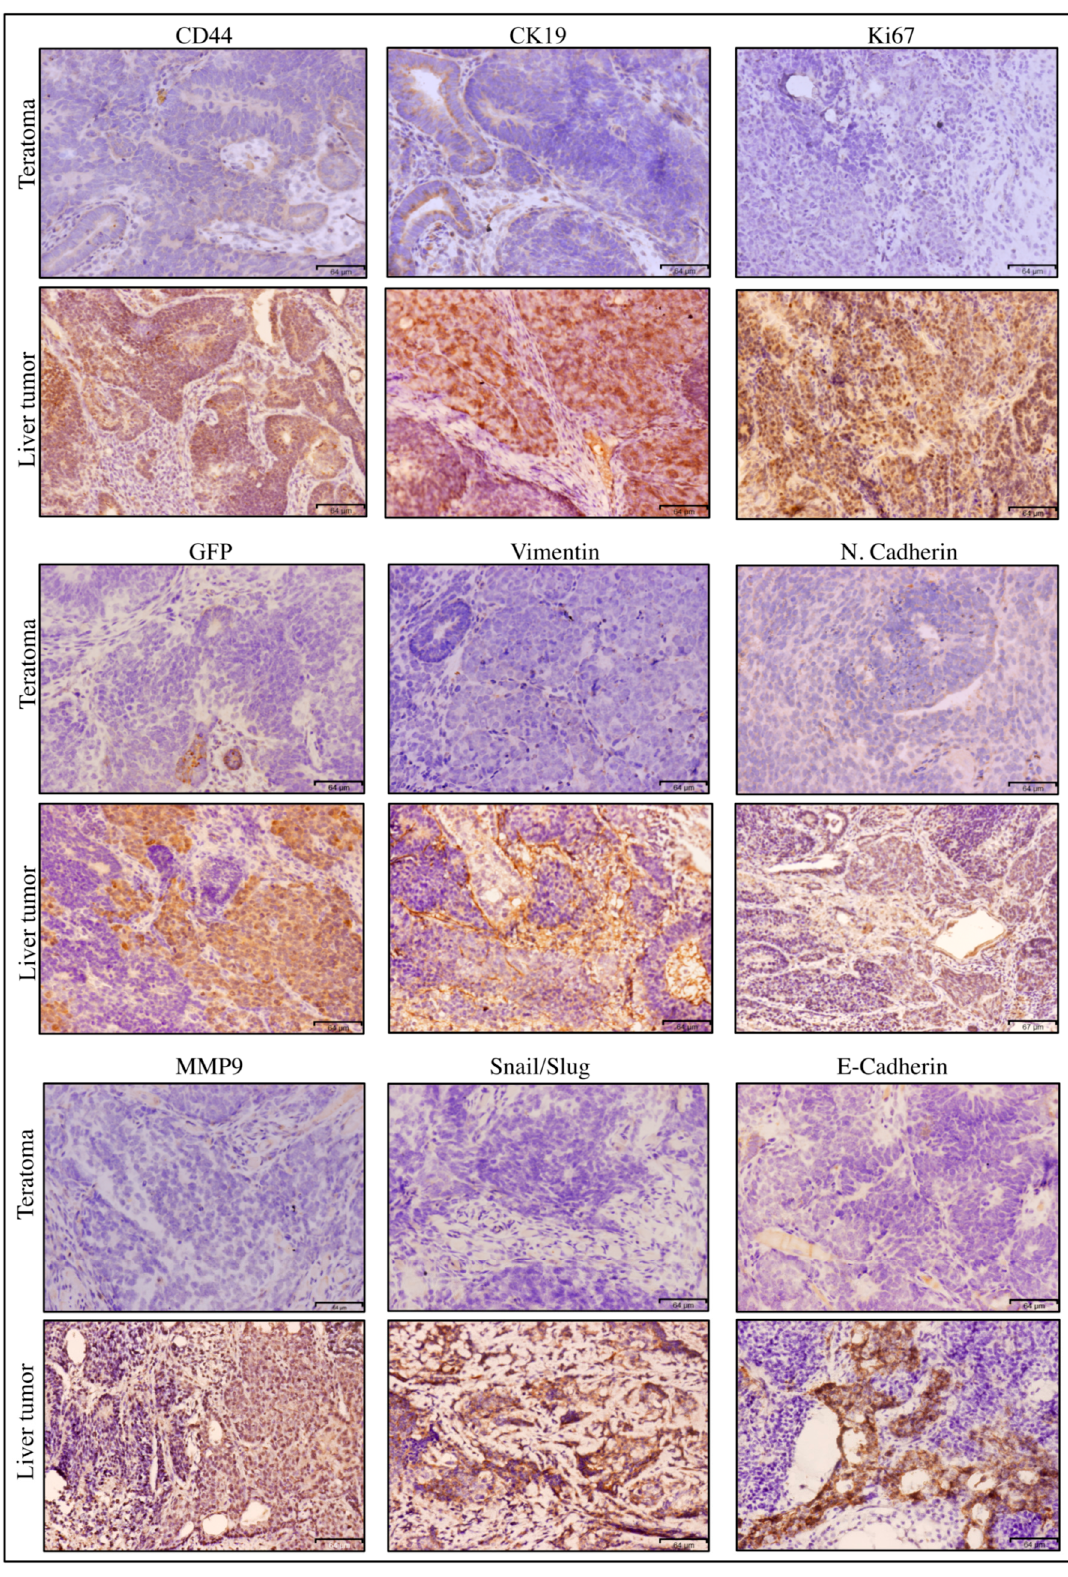
Figure 3. Immunohistochemistry (IHC) of miPS-Huh7cm cell-derived primary tumor in liver against CD44, CK19, Ki67, GFP, Vimentin, N-cadherin, MMP9, Snail/Slug and E-cadherin compared to miPSC-derived teratoma. Scale bars represent 64 μ m.